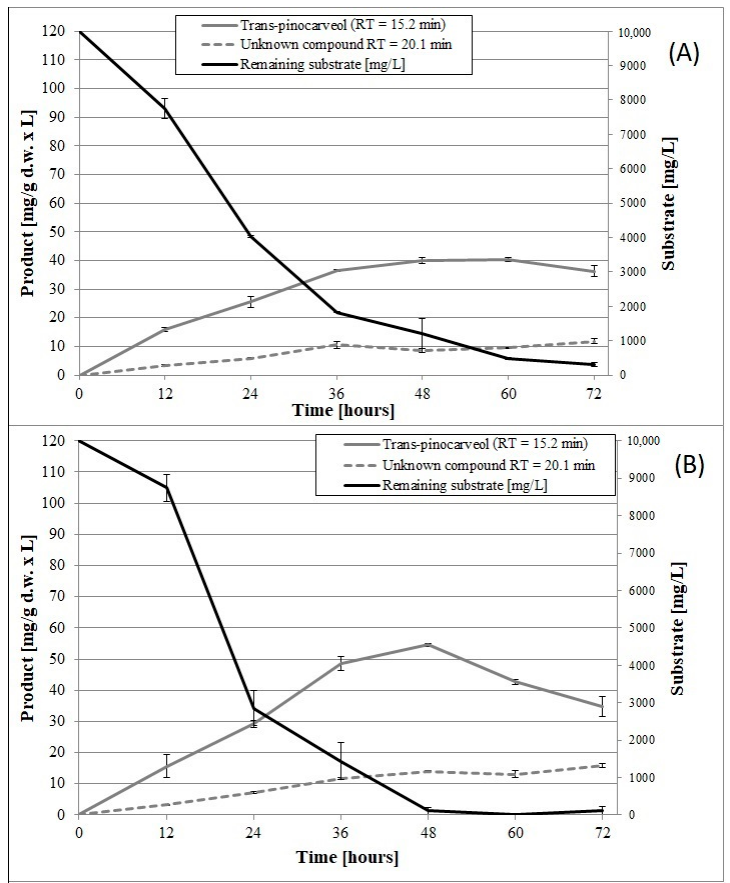
Figure 6. Time course of β -pinene biotransformation by the wild-type strain (A) and mutant 1–6 (B) of the fungus C. pannorum A-1 in phosphate buffer containing 1% glucose. An identical biomass concentration (2.35 g dry mass per L) was used in each sample. Bars represent the standard deviation of two independent tests.